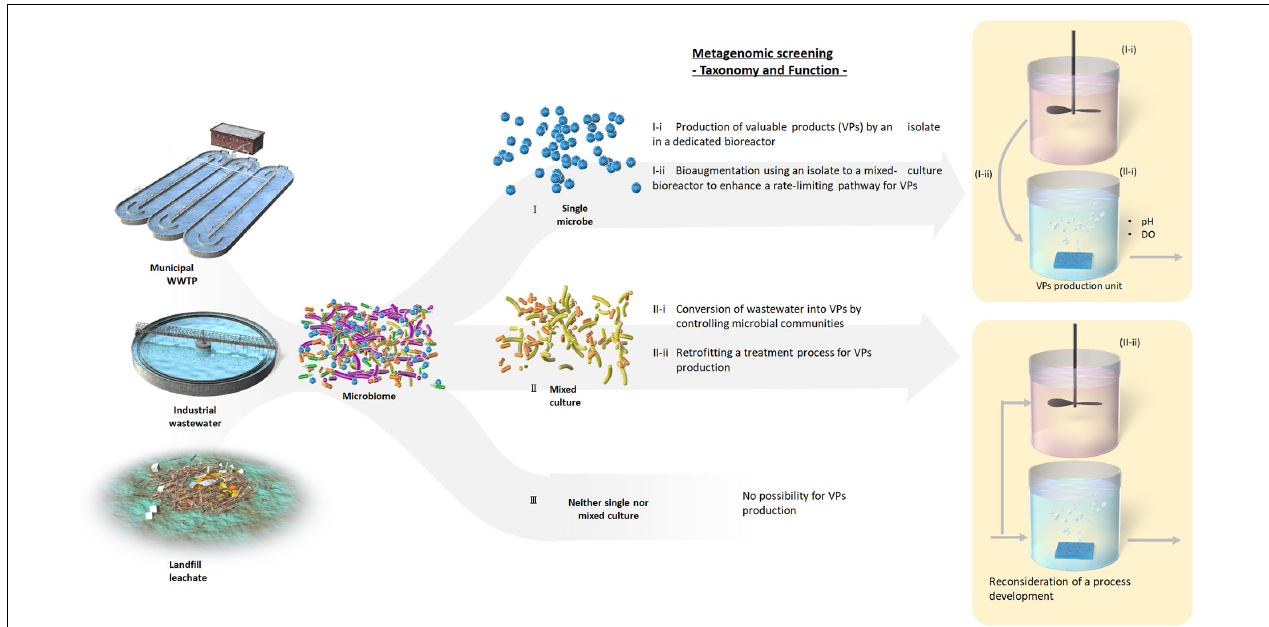
FIGURE 5 | A workflow of a gene-based metagenomic screening method for production of valuable